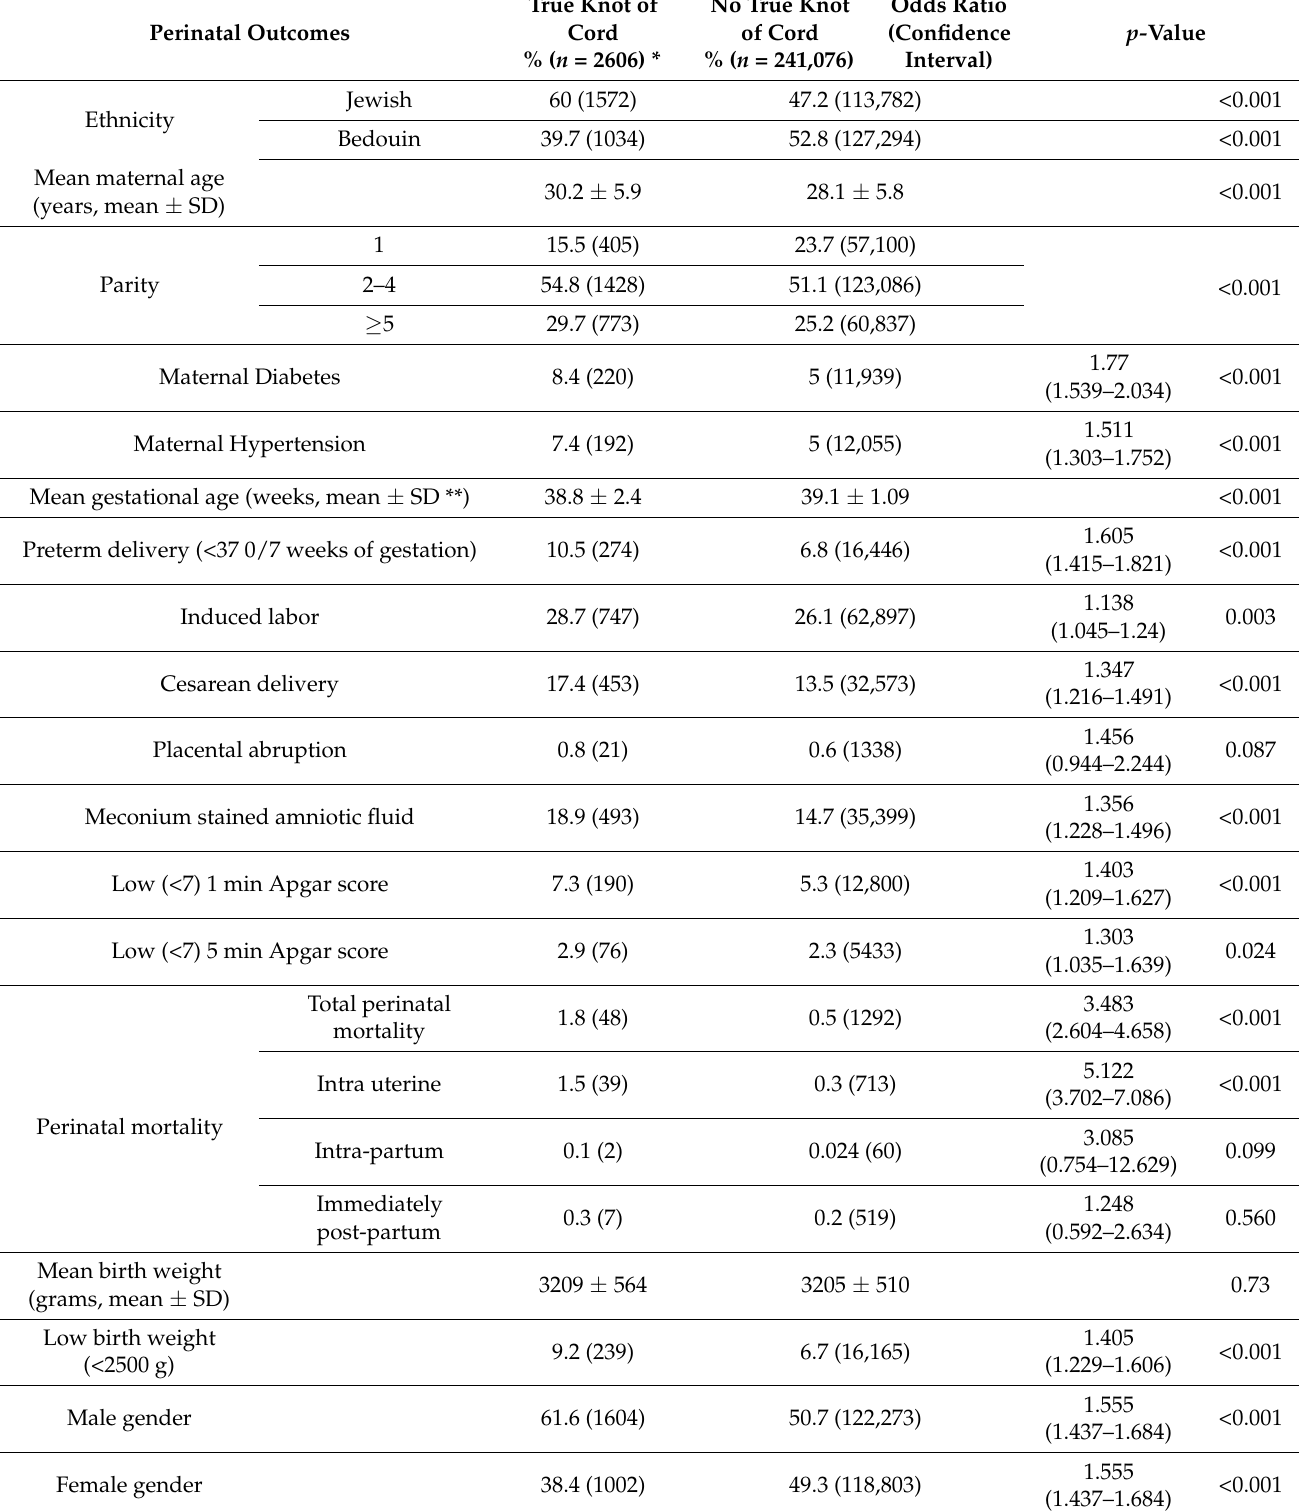
Table 1. Perinatal outcome according to presence or absence of true knot of the umbilical